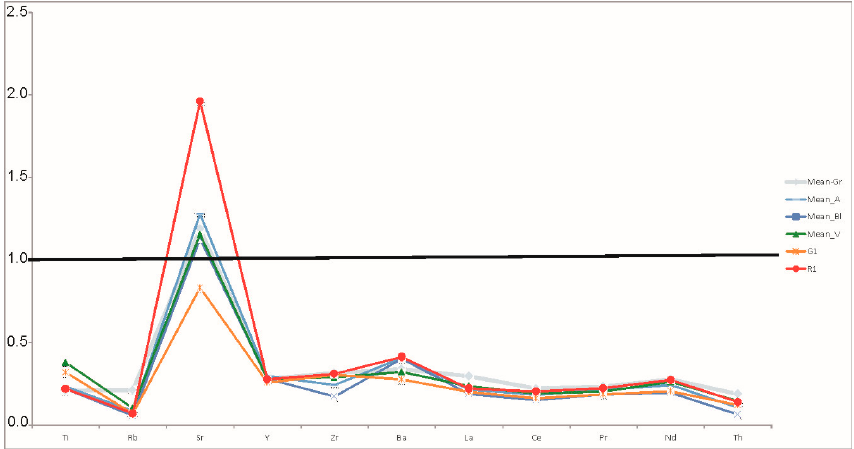
Figure 6. Concentrations of trace elements in glass, normalized to the mean continental upper crust [39]. The mean values of trace element concentrations have been calculated, grouping tesserae by colours: grey, light blue, dark blue, green. Yellow QsG1 and red QsR1 tesserae have been plotted individually. Colouring and Opacifying Agents The glass samples are in different colours: grey, light blue, dark blue, shades of green, red and yellow (Figure 2; Table 1). The colouring is produced, in many cases, by the introduction of transition metals into the glassy matrix. They sometimes combine with each other in various concentrations and oxidation states of metal ions [7]. Common colourants consist of cobalt oxide (CoO) for dark blue, manganese oxide (MnO) for purple, iron oxide (FeO) for green, blue or amber and copper oxide (CuO) for turquoise, blue or green [9]. In addition, cuprite (Cu 2 O) crystals were used in red glasses [40]. In the green and blue tesserae studied here, copper and cobalt are the two main colouring elements